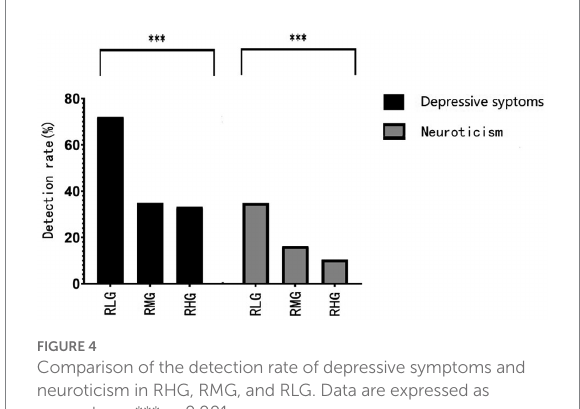
FIGURE 4 Comparison of the detection rate of depressive symptoms and neuroticism in RHG, RMG, and RLG. Data are expressed as percentage. *** p <